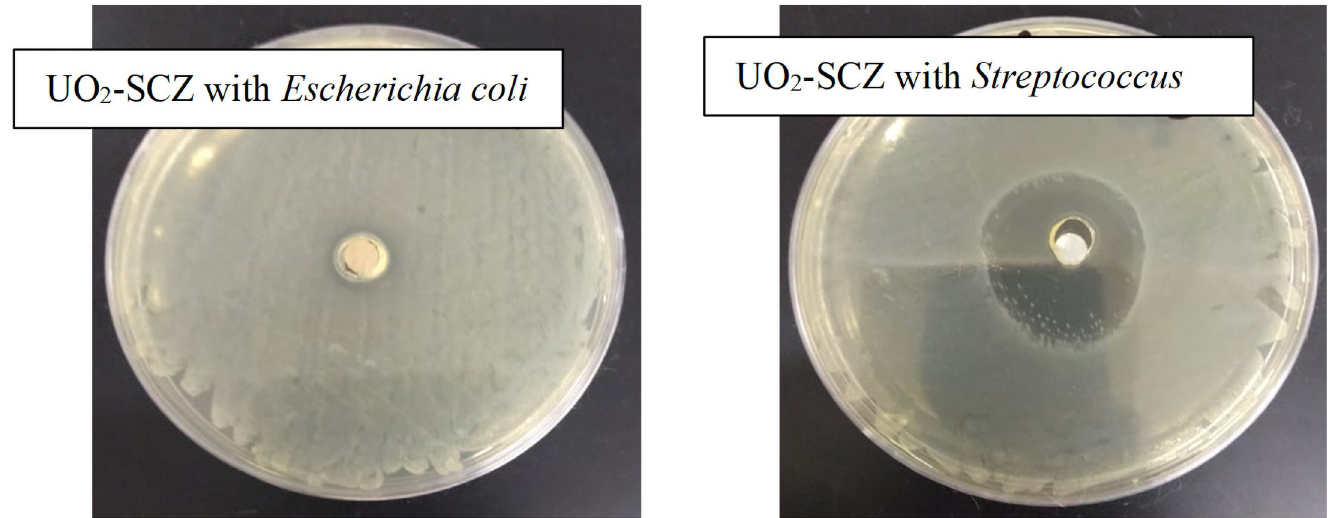
Fig 11. Antibacterial activity of the synthesized (UO2)(OAc)2(SCZ)] with gram-negative bacteria ( Escherichia coli ) and gram-positive bacteria ( Staphylococcus aureus ).